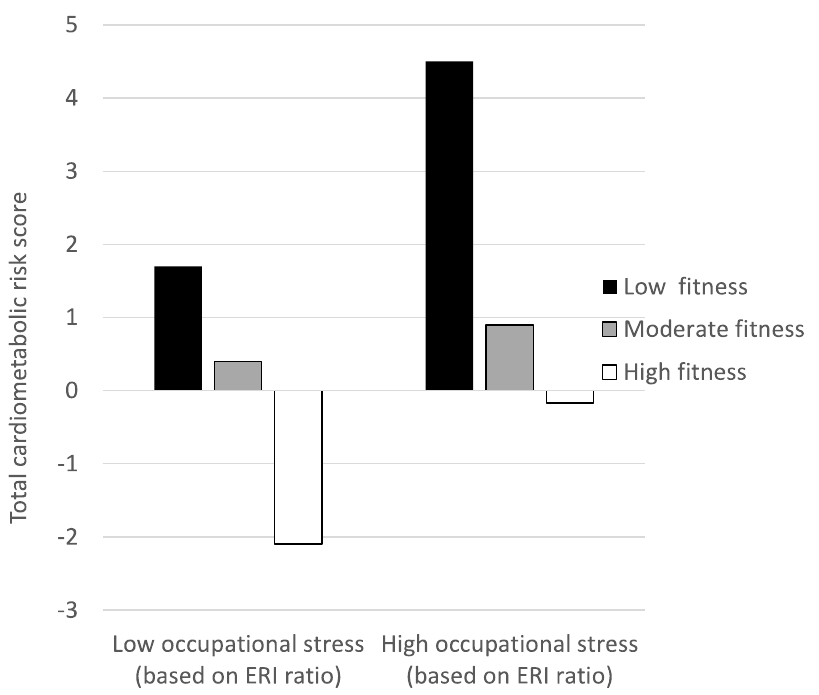
Figure 1. Graphical representation of the interaction between occupational stress (as assessed with the ERI ration) and cardiorespiratory fitness on total cardiometabolic risk. Note: Higher scores on the total cardiometabolic risk index reflect higher cardiometabolic risk.